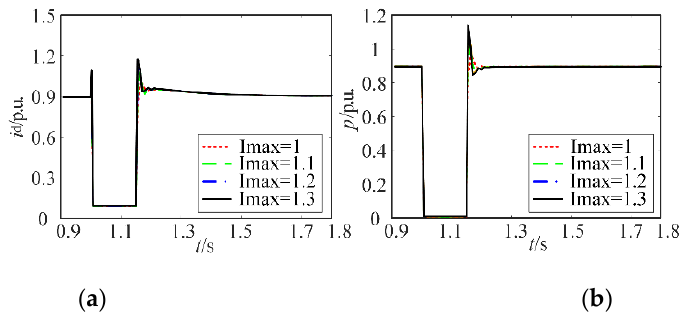
Figure 12. Simulation results in cases (1)–(4) of the fault of Bus7: ( a ) active current; ( b ) active output.